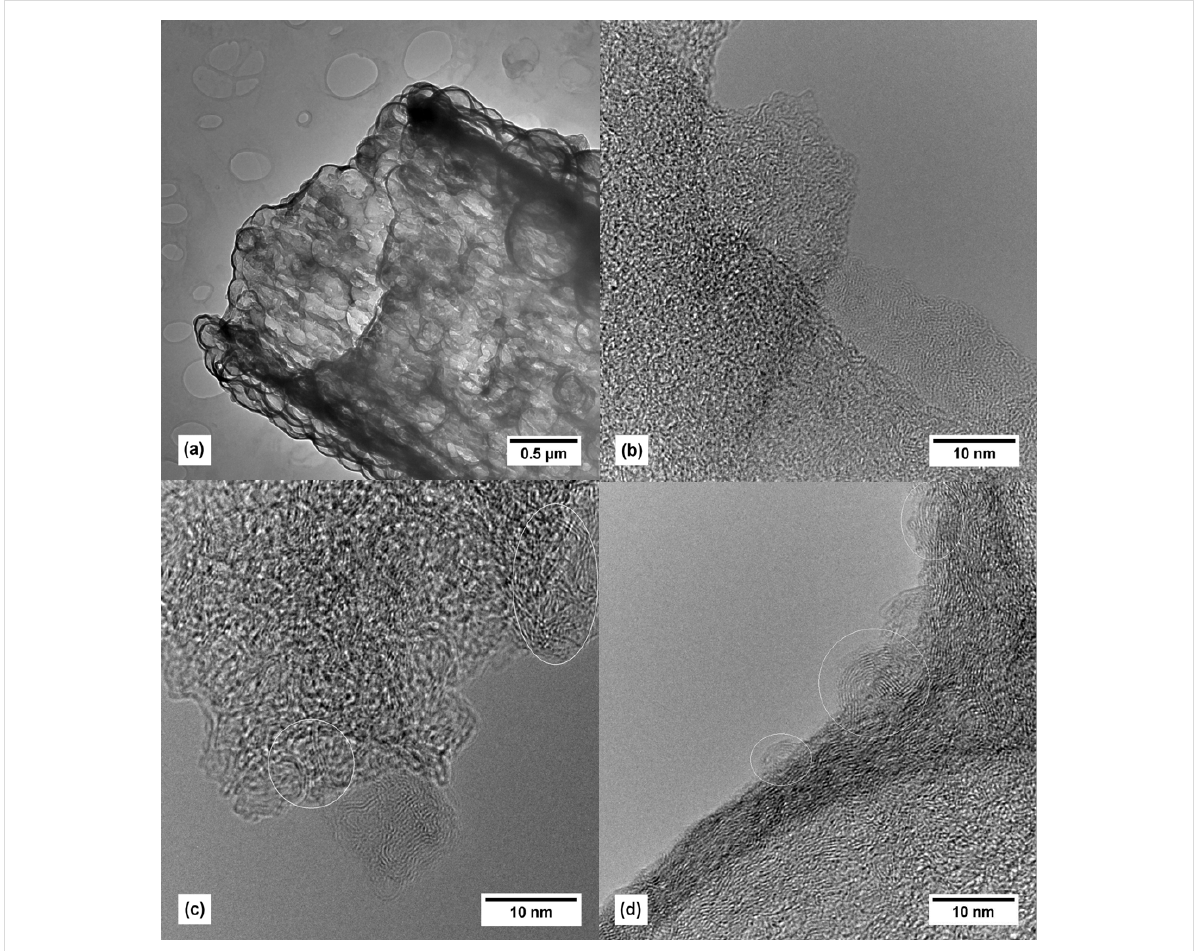
Figure 3: TEM images of the carbon tubes ( 4 ) calcined at 950 °C (a,b), 1300 °C (c) and 1600 °C (d). Circles indicate graphitic regions with fullerene- or onion-like structural moieties.